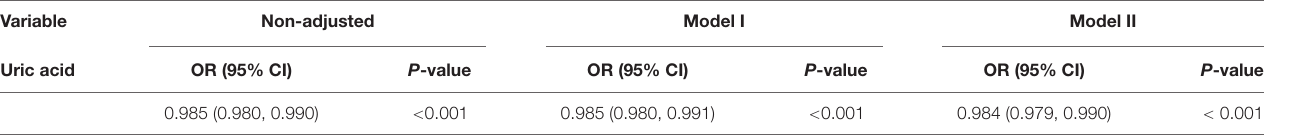
TABLE 3 | Multivariate regression for effect of serum uric acid levels on Meige’s